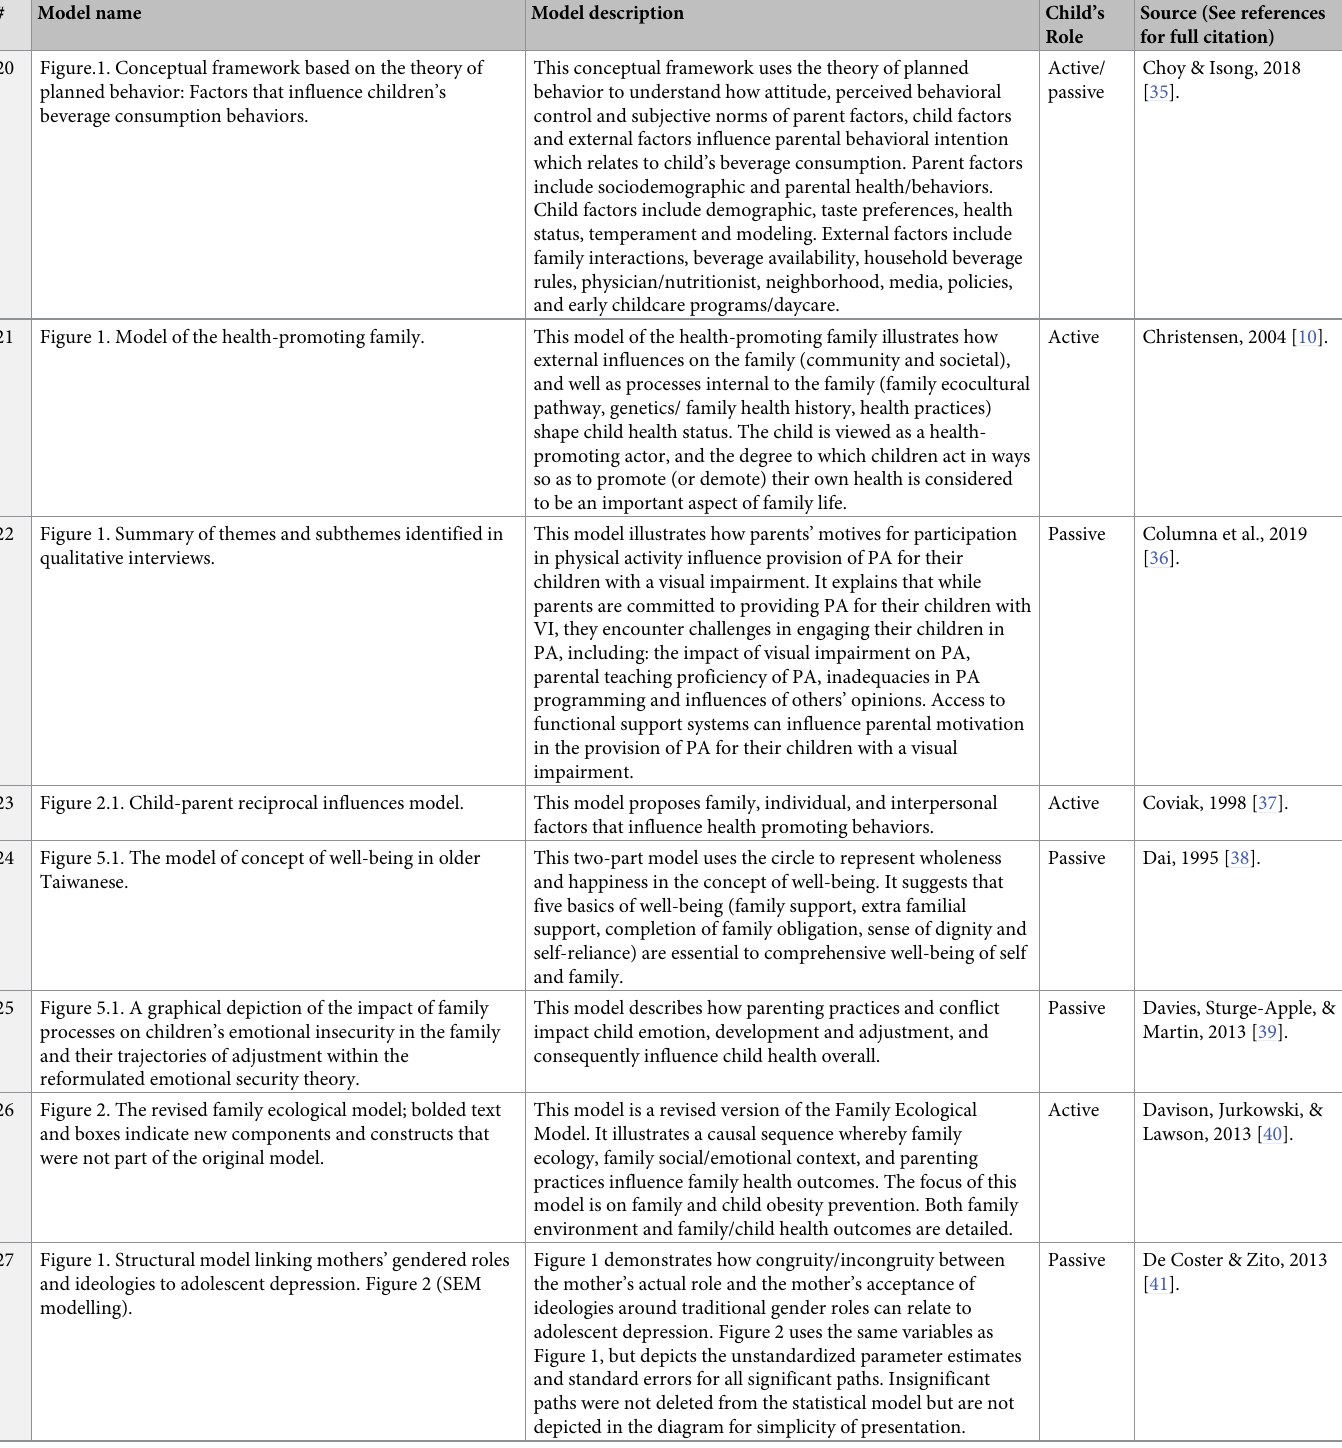
Figure.1. Conceptual framework based on the theory of planned behavior: Factors that influence children’s beverage consumption behaviors.